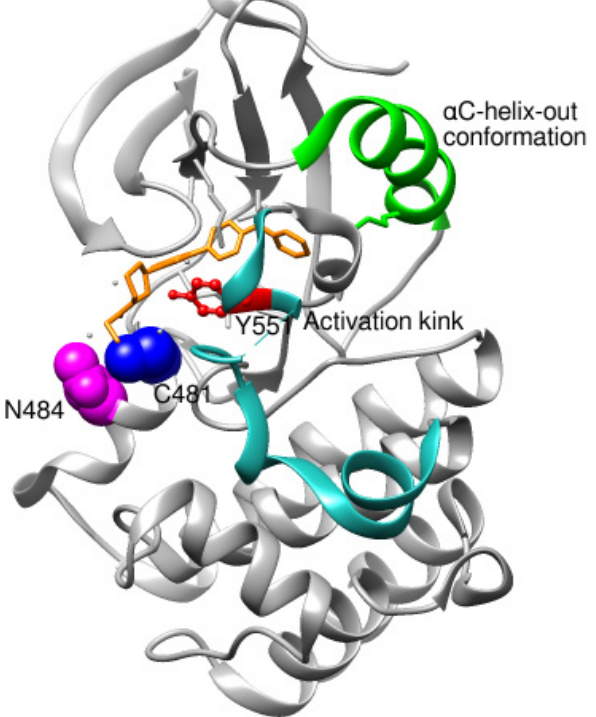
Figure 4. Kinase domain of BTK in α C-helix-out conformation as a result of ibrutinib binding. Asn484 is essential for the stability of intermediates during the nucleophilic reaction between ibrutinib and Cys481.